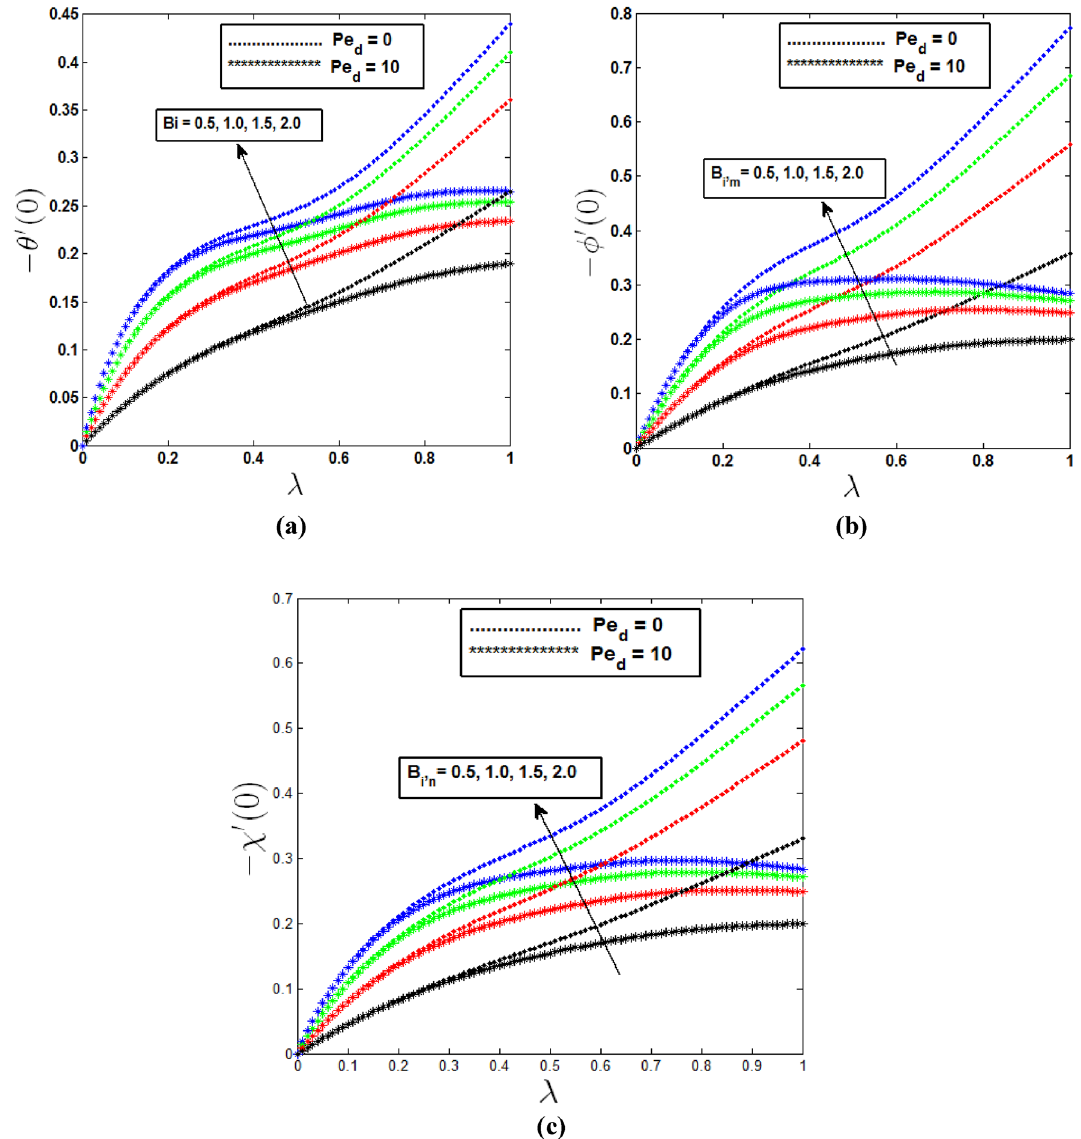
Figure 7. Effects of Biot numbers on ( a ) heat transfer rate, ( b ) mass transfer rate, ( c ) Motile microorganism transfer rate in free, forced and mixed convection